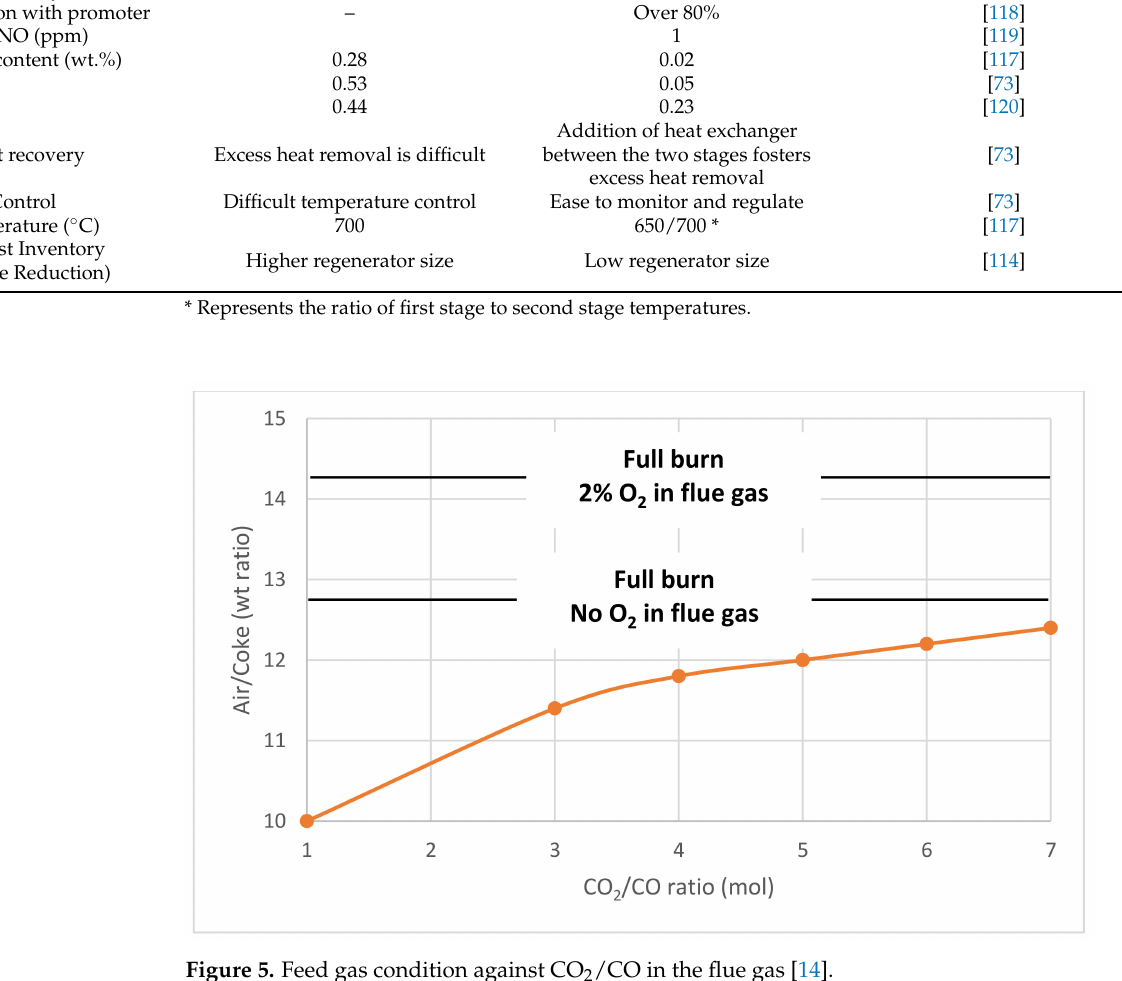
Figure 5. Feed gas condition against CO 2 /CO in the flue gas